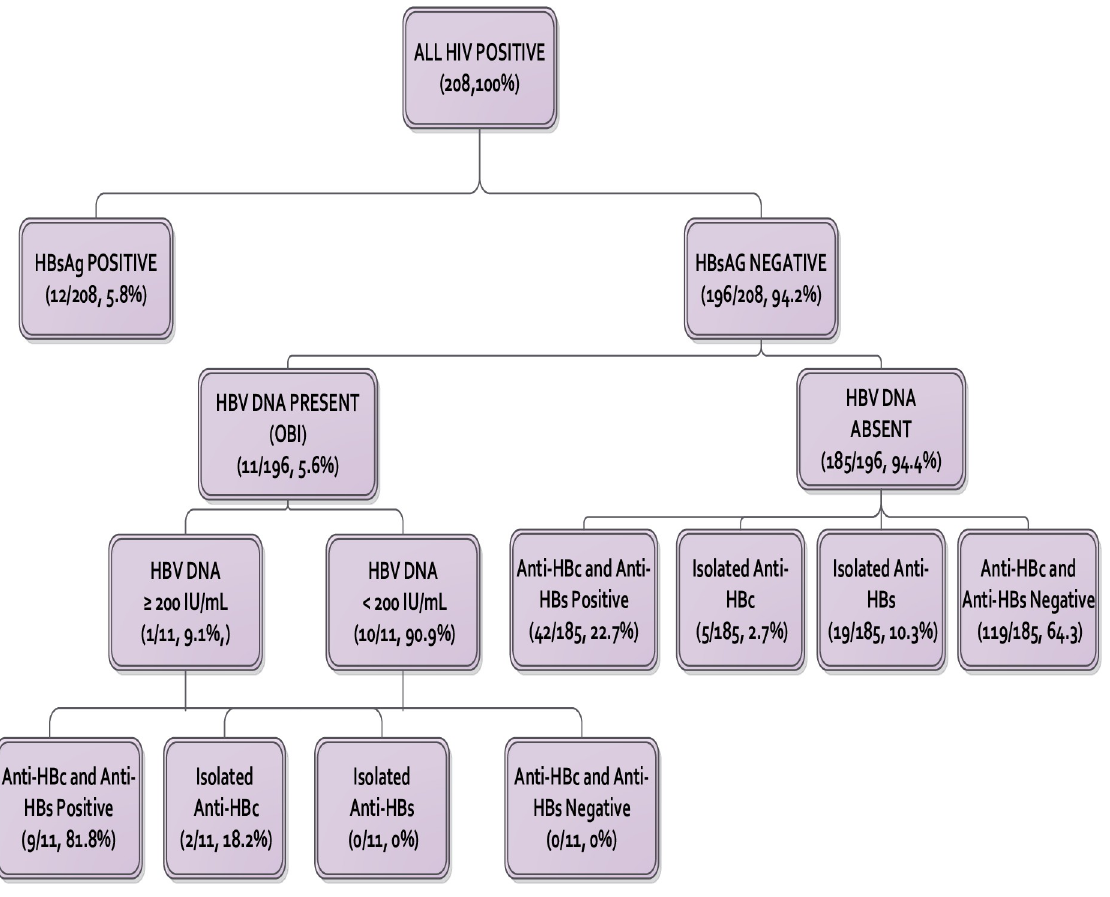
Fig 2. HBV serological and DNA